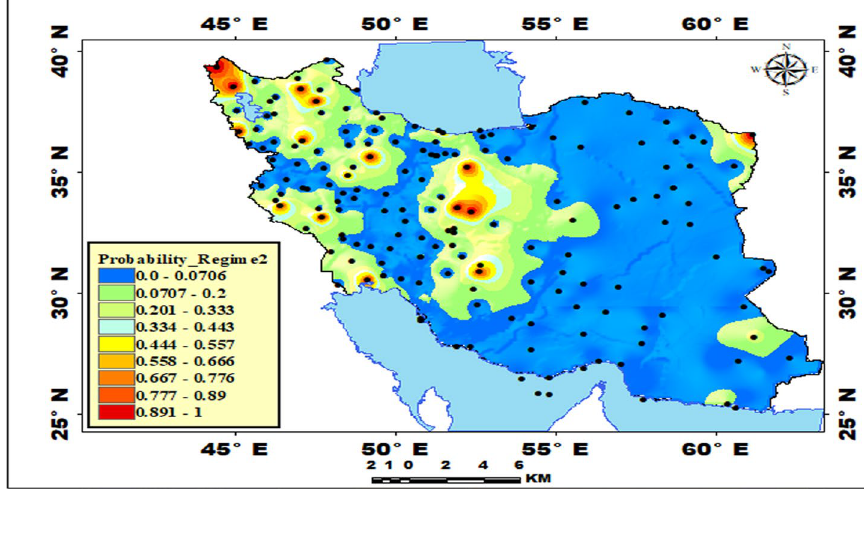
Fig. 7 The regular reoccur- rence of daily rainfall based on the regime2 model